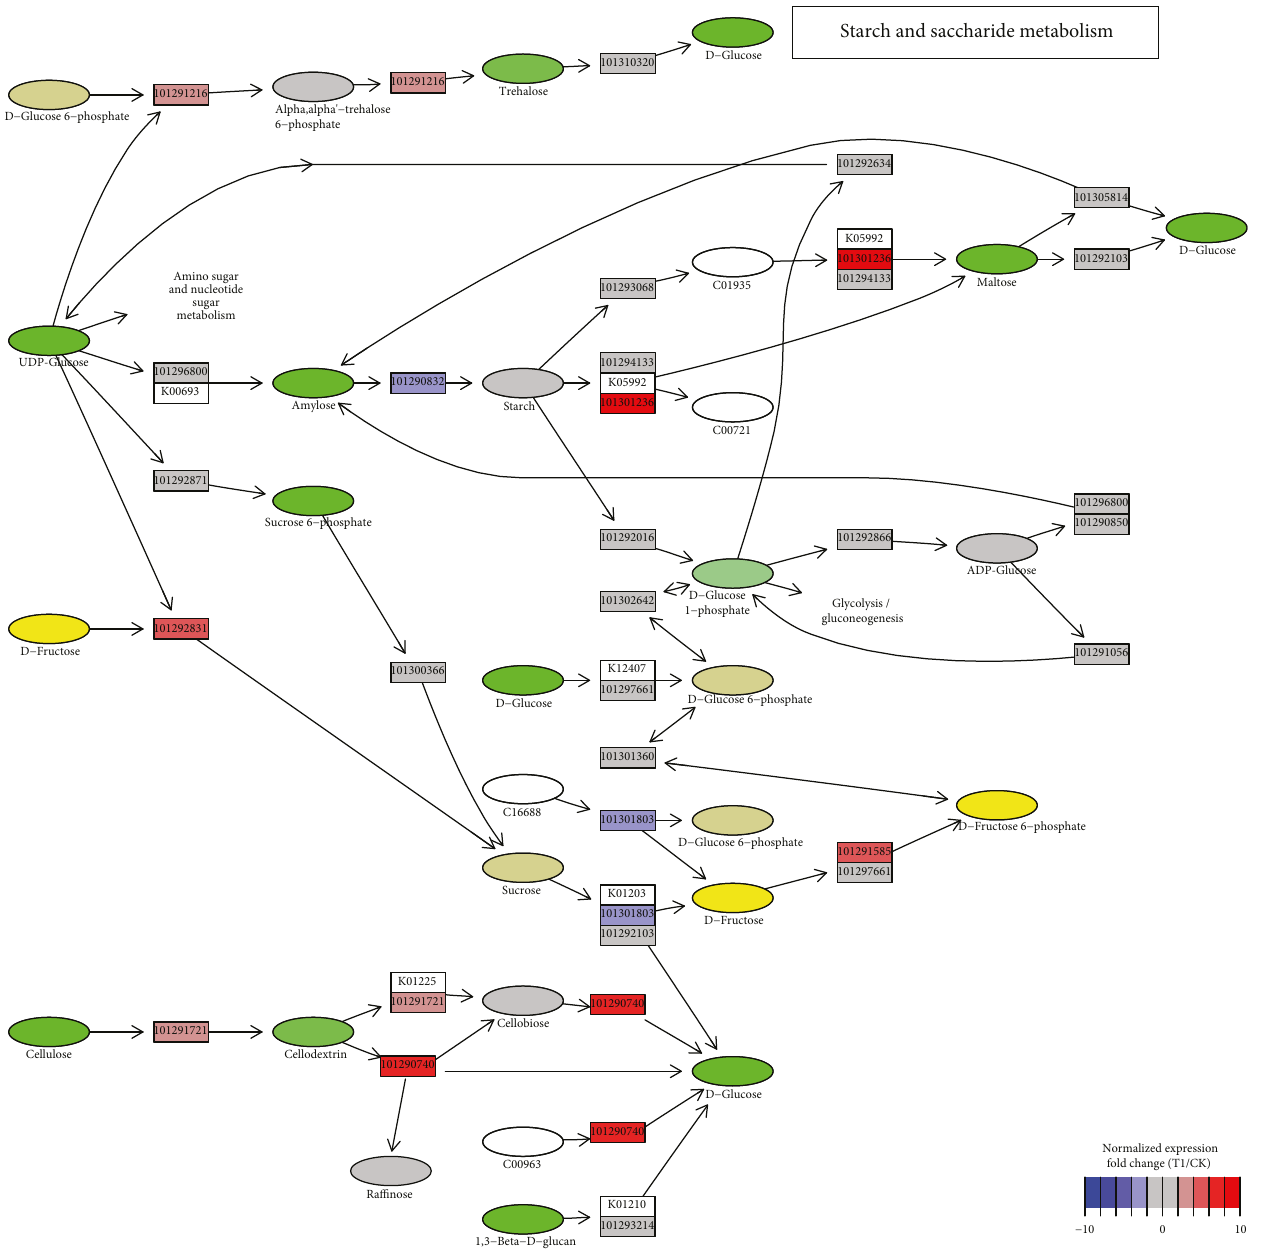
Figure 4: Starch and saccharide metabolism mapped with relative expression levels (T1 vs . CK). Gene ID of F. vesca is indicated at the corresponding gene node if there